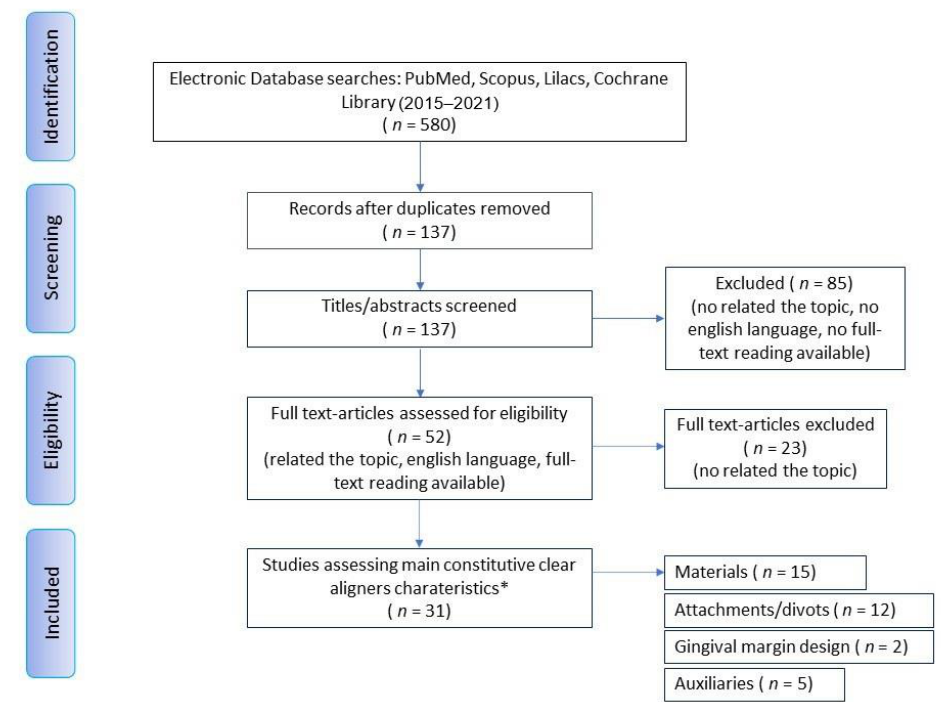
Figure 1. Review flow diagram. Caption: the PRISMA flow diagram for the systematic review detailing the database searches, the number of abstracts screened and the full texts retrieved. * Some articles analyzed > 1 characteristic.